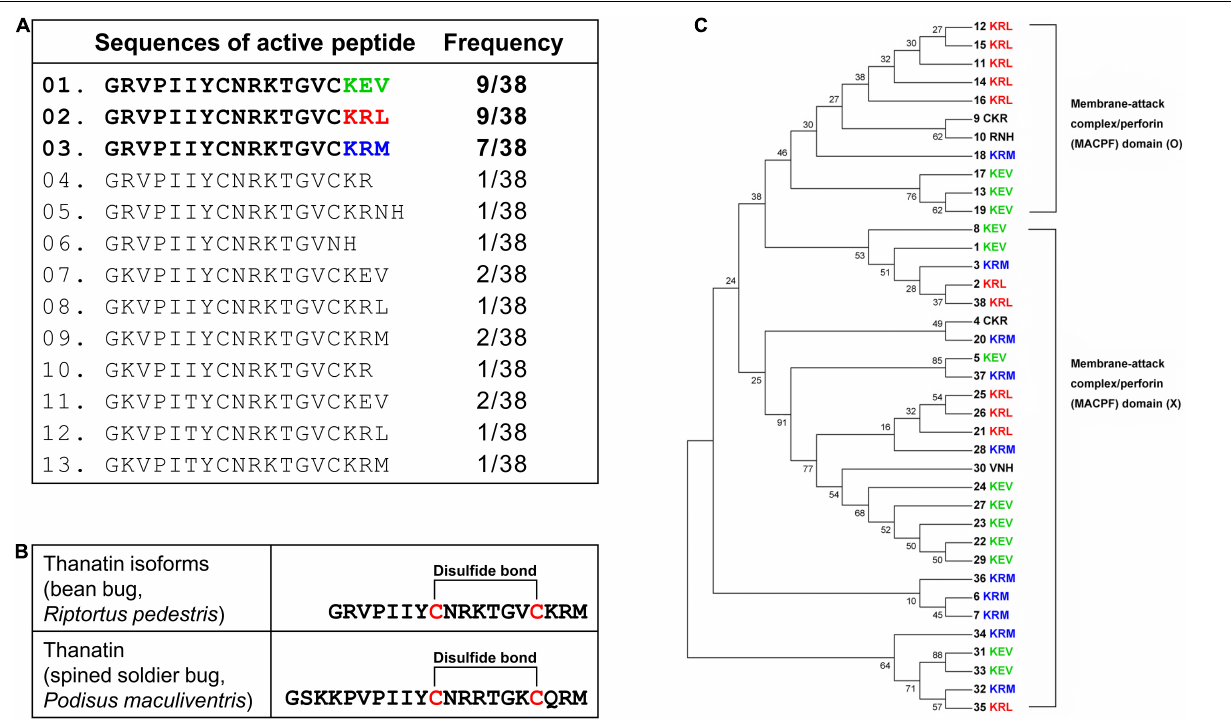
FIGURE 2 | Alignment of active thanatin isoforms. (A) The alignment of amino acid sequences and frequency of thanatin isoforms. (B) Comparison of amino acid sequences and structure between thanatin KRM isoform from R. pedestris and thanatin of P. maculiventris . The line between cysteine residues represents a disulfide bond. (C) Phylogenetic tree using precursor sequences of thanatin isoforms. Thanatin precursor proteins with (upper clade, O) or without (bottom clade, X) the membrane attack complex/perforin (MACPF) domain.